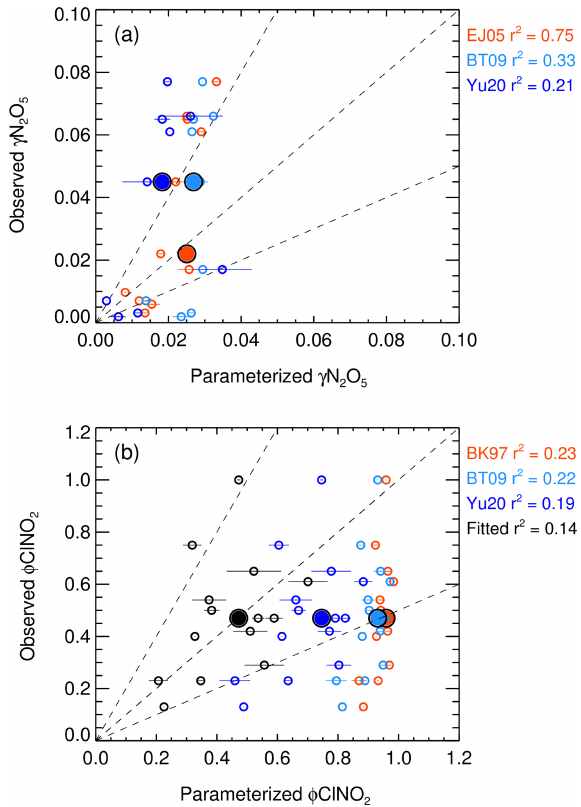
Figure 5. The inter-comparison of observation and parameteriza- tion of the N 2 O 5 uptake coefficient (a) and ClNO 2 yield (b) . The larger size of solid dots represents the median results. The parame- terizations of EJ05, BT09, Yu20, and BK97 was cited from Evans and Jacob (2005), Bertram and Thornton (2009), Yu et al. (2020), Behnke et al. (1997) respectively. The fitted ClNO 2 yield (colored black) in panel (b) shows the best-fitting result in the study by adopting the k 4 /k 3 of